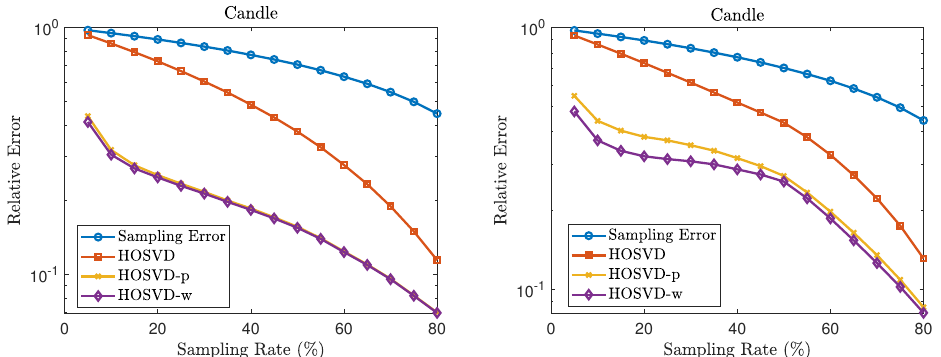
Figure 7. Relation between relative error and sampling rate for the dataset “candle_4_A” using [ 5,5,5 ] as the input rank for HOSVD process. The left figure records the relative error for the uniform sampling pattern and the right figure for the non-uniform sampling pattern. The sampling error stands for the relative error between the original video and the video with masked entries estimated √ to be zeros, hence should approximately equal to 1 − SR , where SR is the sampling